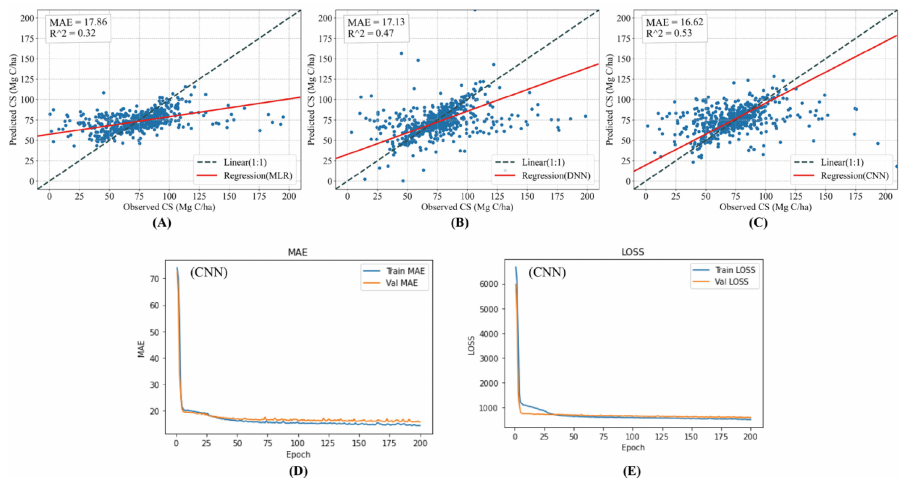
Figure 5. ( A ) is the fitting result from the MLR; ( B ) is the fitting result from the DNN; ( C ) is the fitting result from the CNN; ( E ) shows the decline curve of CNN model MAE; ( D ) shows the loss curve of the CNN model training and validation data.